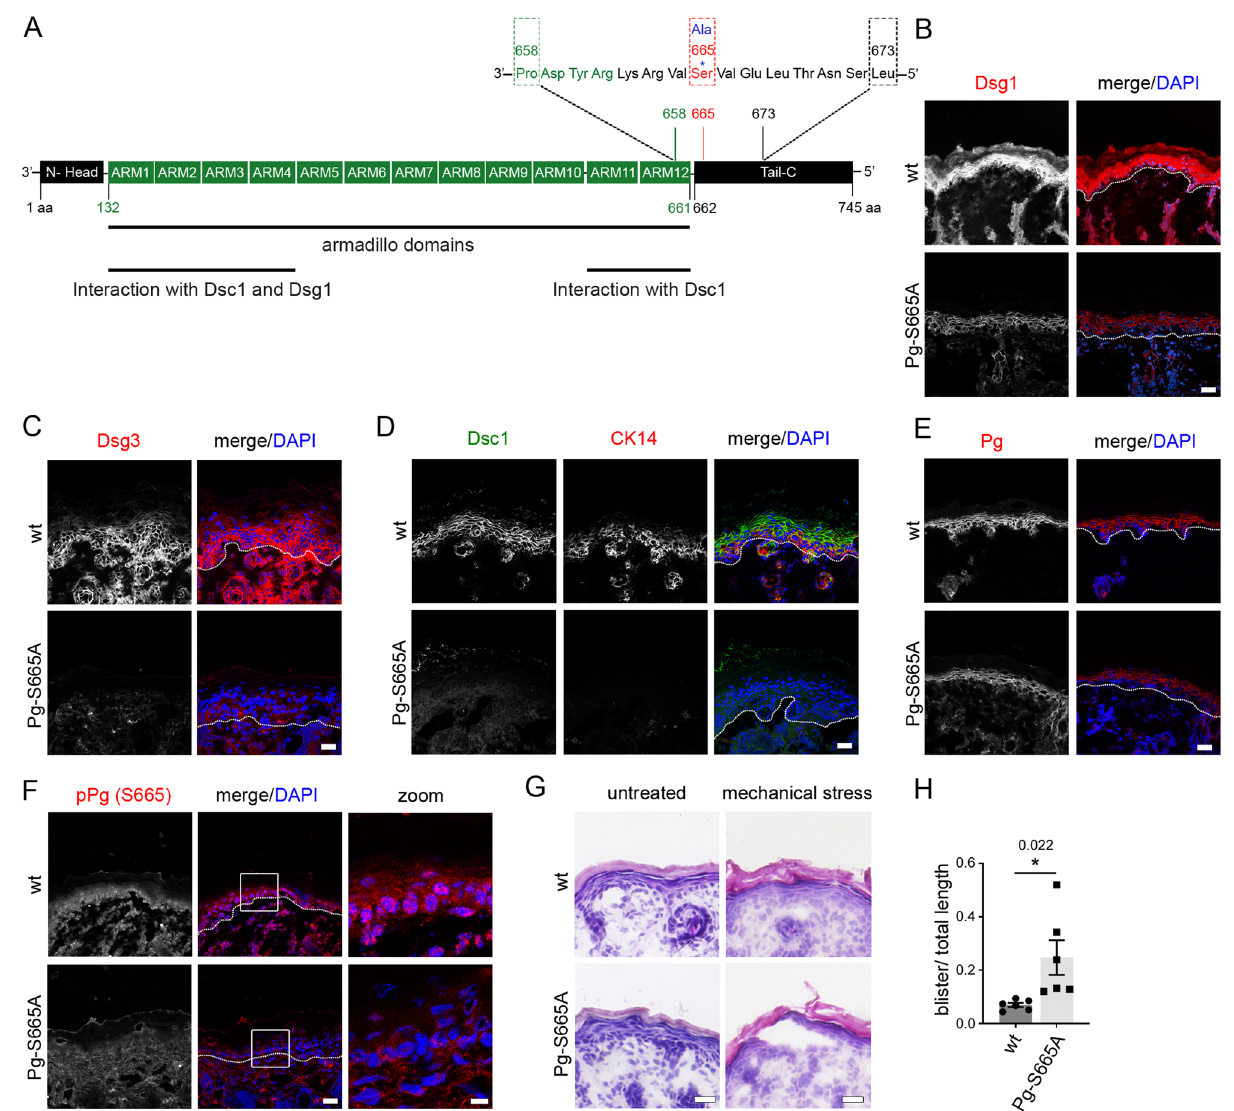
Fig.5|PhosphorylationofPgatS665isimportantfordesmosomaladhesionin murine epidermis. A Introduction of S665A mutation into the plakoglobin (JUP) locus. The phospho-site of interest is located at S665 in the C-terminal tail region. B , C Immunostaining for Dsg1 (wt: n =4, Pg-S665A: n =7) and Dsg3 ( n =3) was diminished in Pg-S665A mice. D Dsc1 and CK14 reveal a differentiation-dependent staining pattern in wt and are almost absent in Pg-S665A mice ( n =5). E Pg is reduced along cell borders in Pg-S665A ( n =6) mice compared to wt ( n =5). F pPg- S665 was present in a dotted fashion along cell borders and in the nuclei in wt ( n =3) but not in Pg-S665A ( n =6) epidermis. White rectangles represent areas for